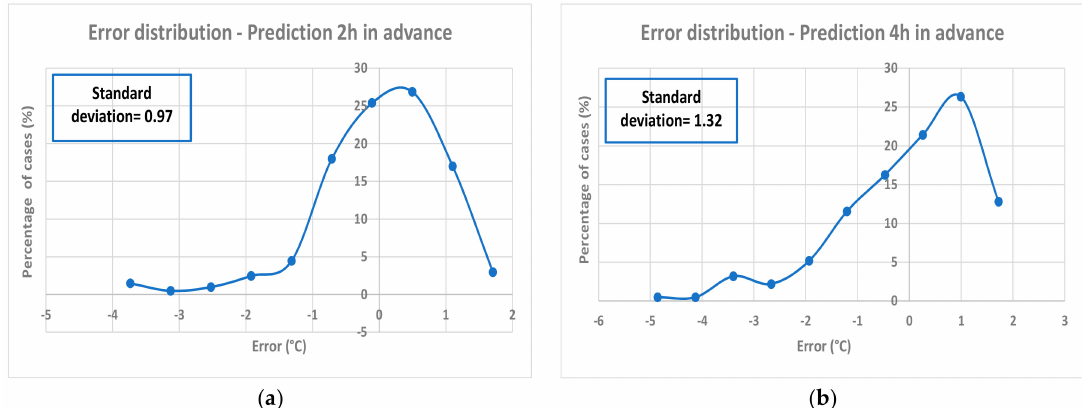
Figure 10. Distribution of error forecasting (input parameter = outdoor temperature): ( a ) prediction for 2 h; and ( b ) prediction for 4